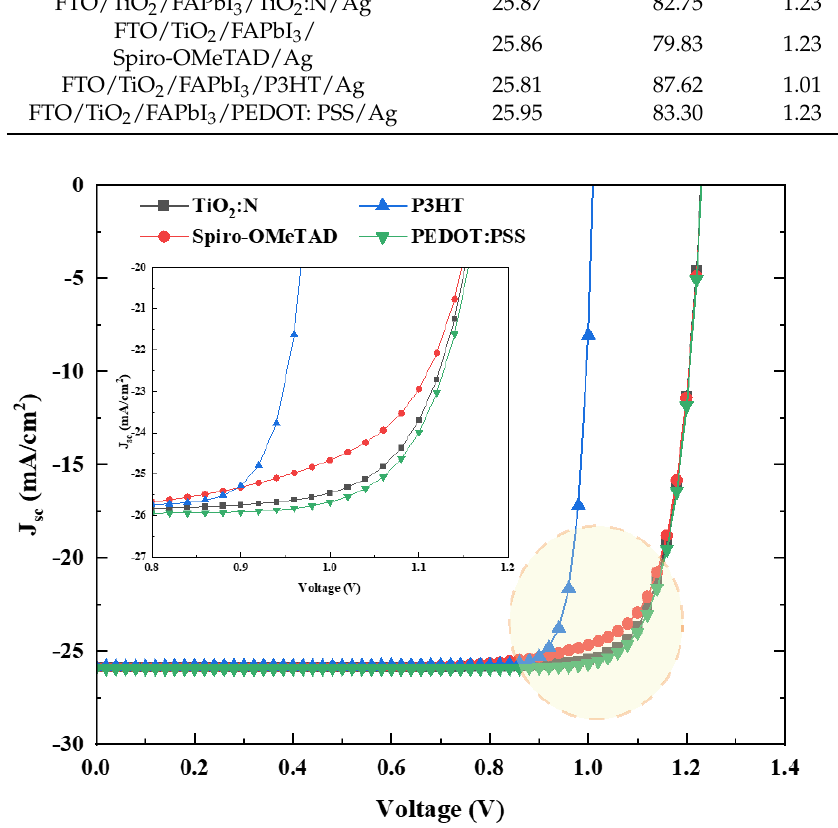
Figure 7. J-V characteristic curve for the HTL comparative analysis with a magnified view that depicts the drift patterns between 0.8–1.2 V.